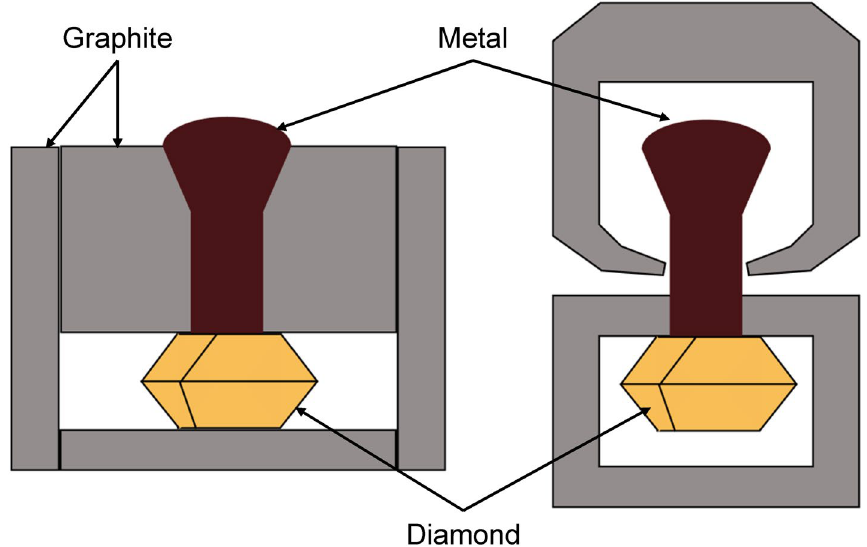
Figure 6. The scheme showing the deposition of the brazing metal onto diamond crystal and tensile testing of the metal–diamond interphase (adapted from 18 ) (https:// www. figma.